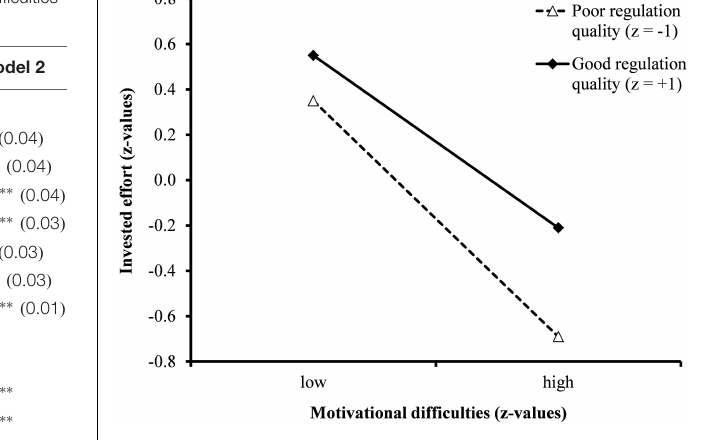
difficulties. All found effects were robust, i.e., did not change substantially in their size and stayed statistically